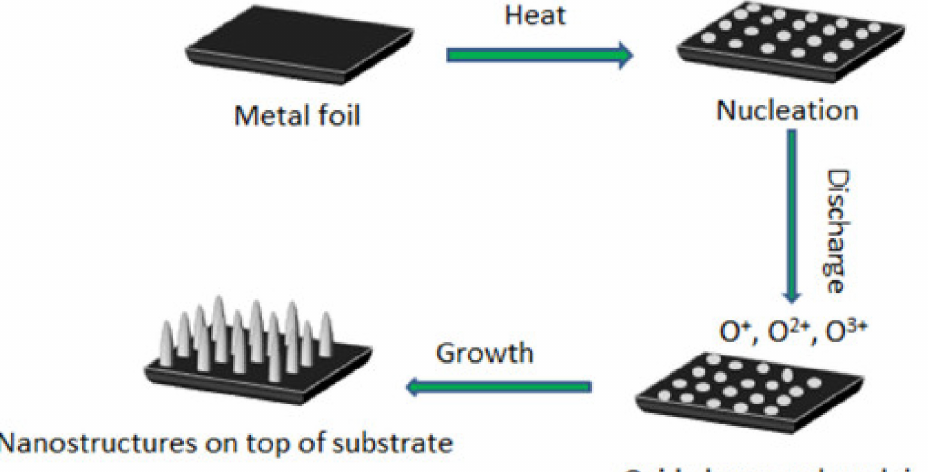
Figure 10. Schematic illustration of the initial stages of the growth process for the metal oxide nanostructures produced under plasma. These stages lead to the nucleation, nanowire growth, and formation of a thin oxide layer. Adapted from [124], under the terms of the Creative Commons CC BY